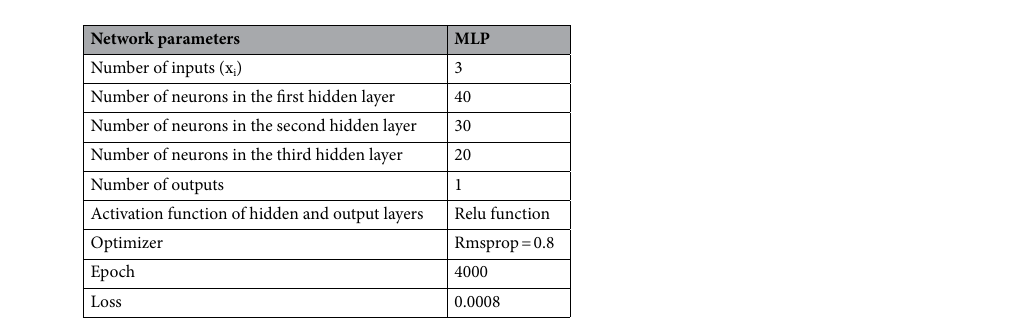
Table 3. Specifications of the trained MLP neural network model.